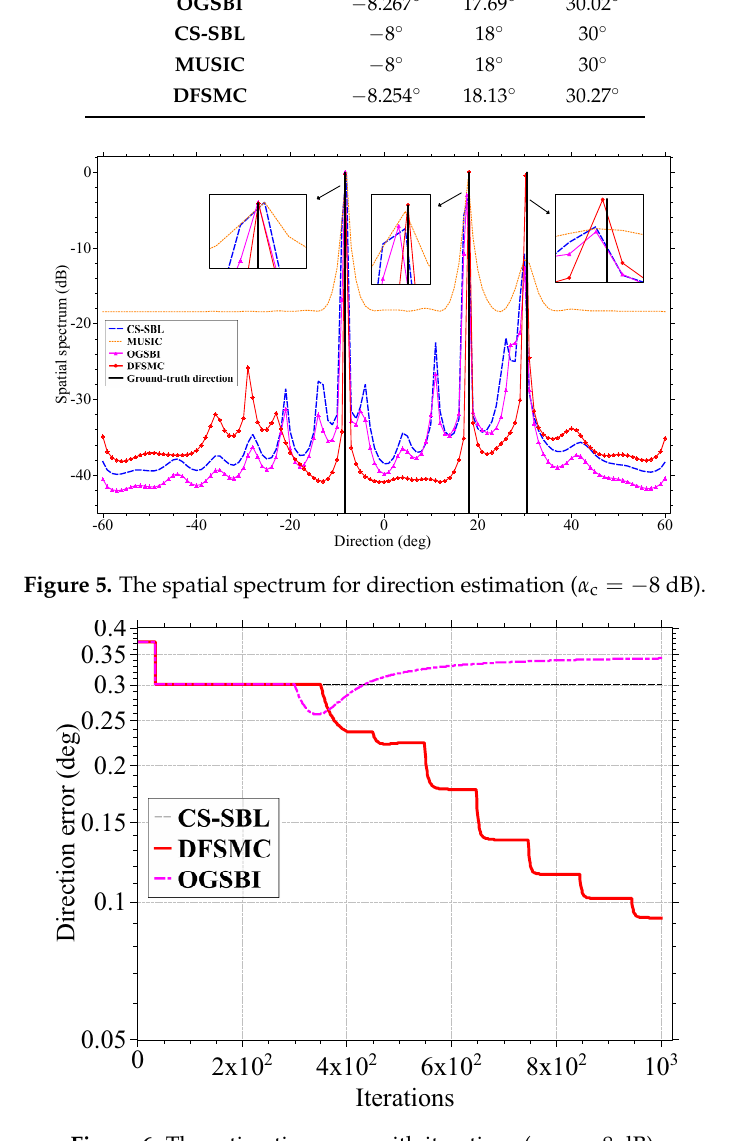
Figure 6. The estimation error with iterations ( α c = − 8